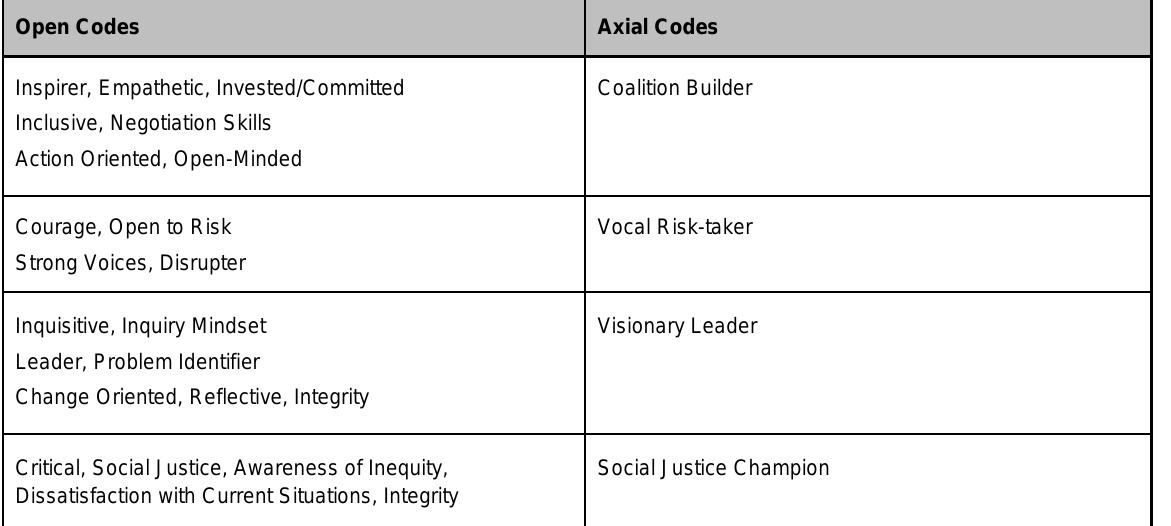
Table 1. Profile of the